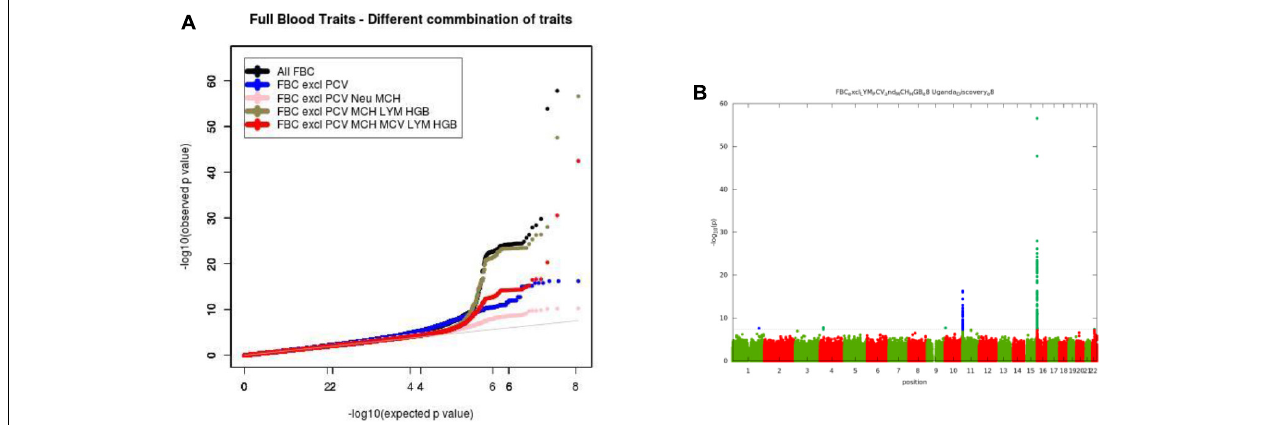
FIGURE 4 | (A) QQ plot of genome-wide associations for all FBC excluding highly correlated traits: PCV, MCH, Hgb, and LYM. (B) Manhattan plots of genome-wide associations for all FBC after highly correlated traits: PCV, MCH, Hgb, and LYM were excluded from the analysis.